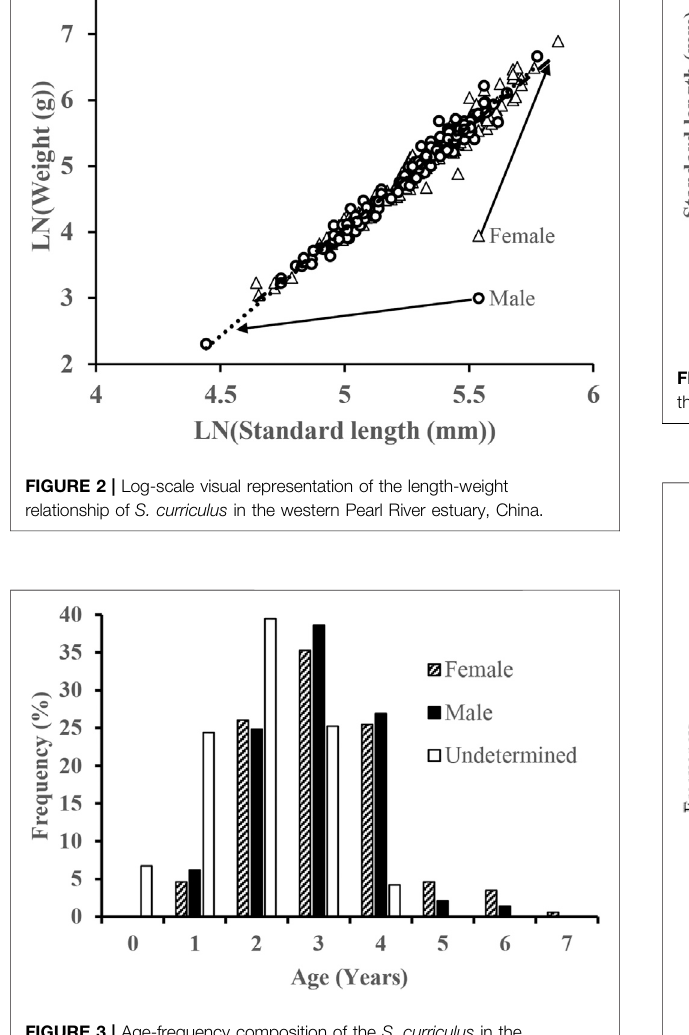
FIGURE 3 | Age-frequency composition of the S. curriculus in the western Pearl River estuary, China.